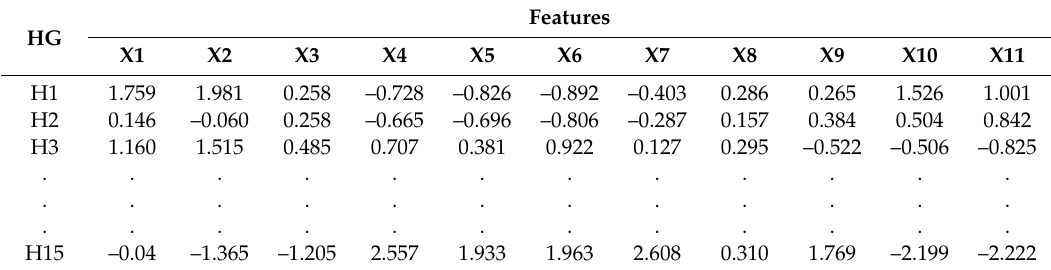
Table 5. Normalised data of the healthy group (HG).